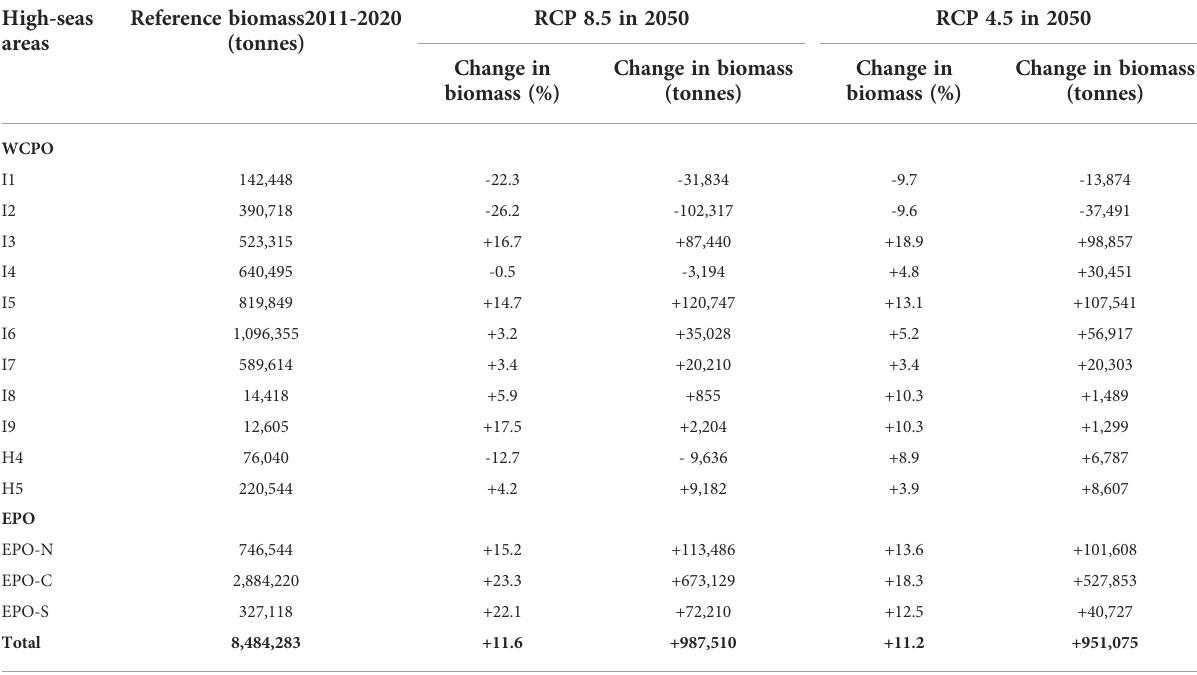
TABLE 1 Projected changes in total biomass of the three tropical tuna species caught by purse seine (skipjack, yellow fi n and bigeye tuna) in high seas areas of the Western and Central Paci fi c Ocean (WCPO) and Eastern Paci fi c Ocean (EPO) under RCP 8.5 and RCP 4.5 greenhouse gas emission scenarios by 2050, relative to reference biomass for the period 2011 −